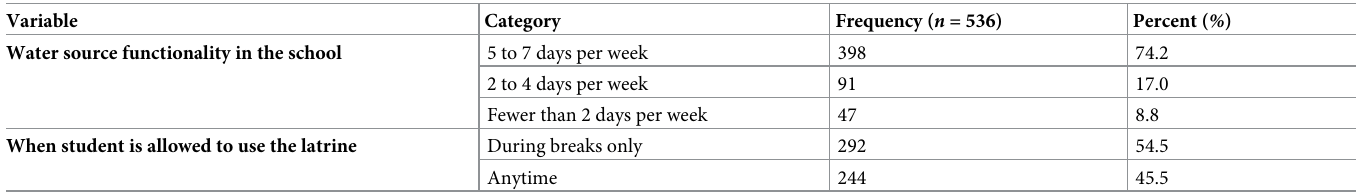
Table 5. Water, sanitation, and hygiene-related issues among high schools of Dessie City, Amhara Region, northeastern Ethiopia, 27 January to 6 March 2020.